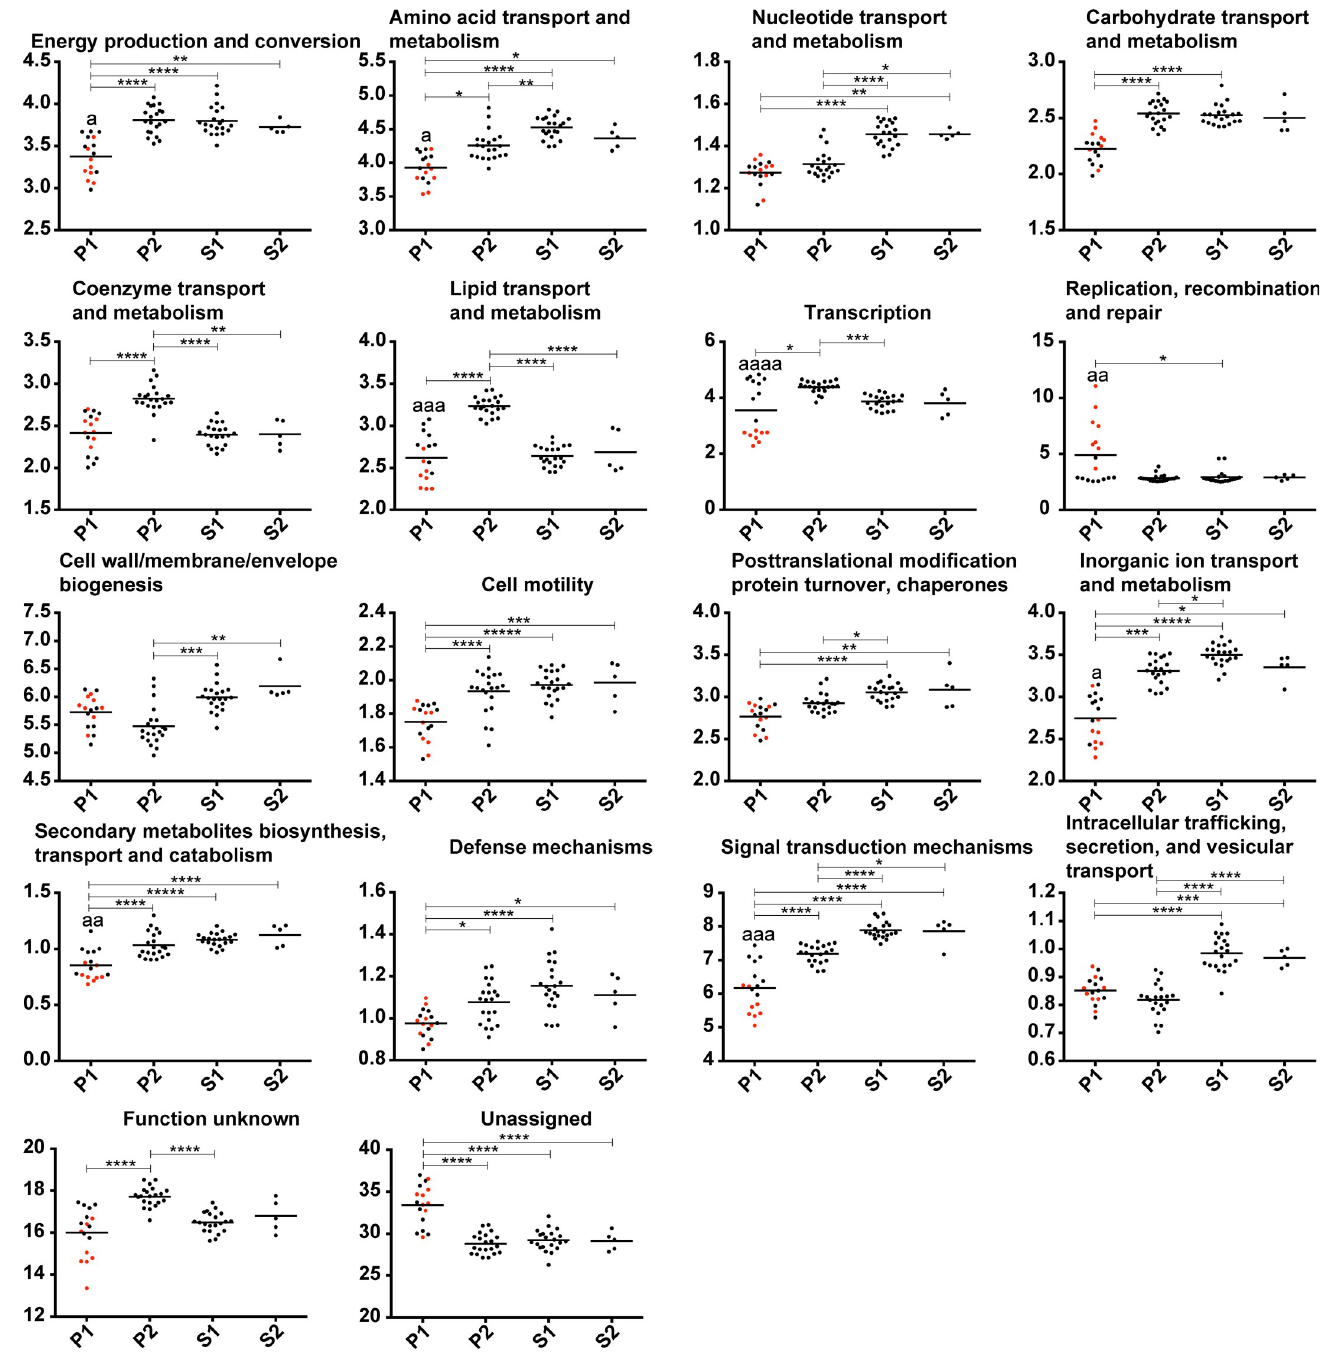
Fig 5. Distribution in functional categories of the predicted CDSs (%). The points representing the genome-specific values of the species that diverged after node 1 in Fig 1 ( L . interrogans , L . kirschneri , L . noguchii , L . santarosai , L . mayottensis , L . borgpetersenii , L . alexanderi and L . weilii ) are in red. The " � " represent the level of significance between the different groups: � P � 0.05, �� P � 0.01, ��� P � 0.001, and ���� P � 0.0001. The level of significance between the two pathogenic groups is represented by the same code, but for the sake of clarity the symbol is "a". Only functional categories showing significant difference are